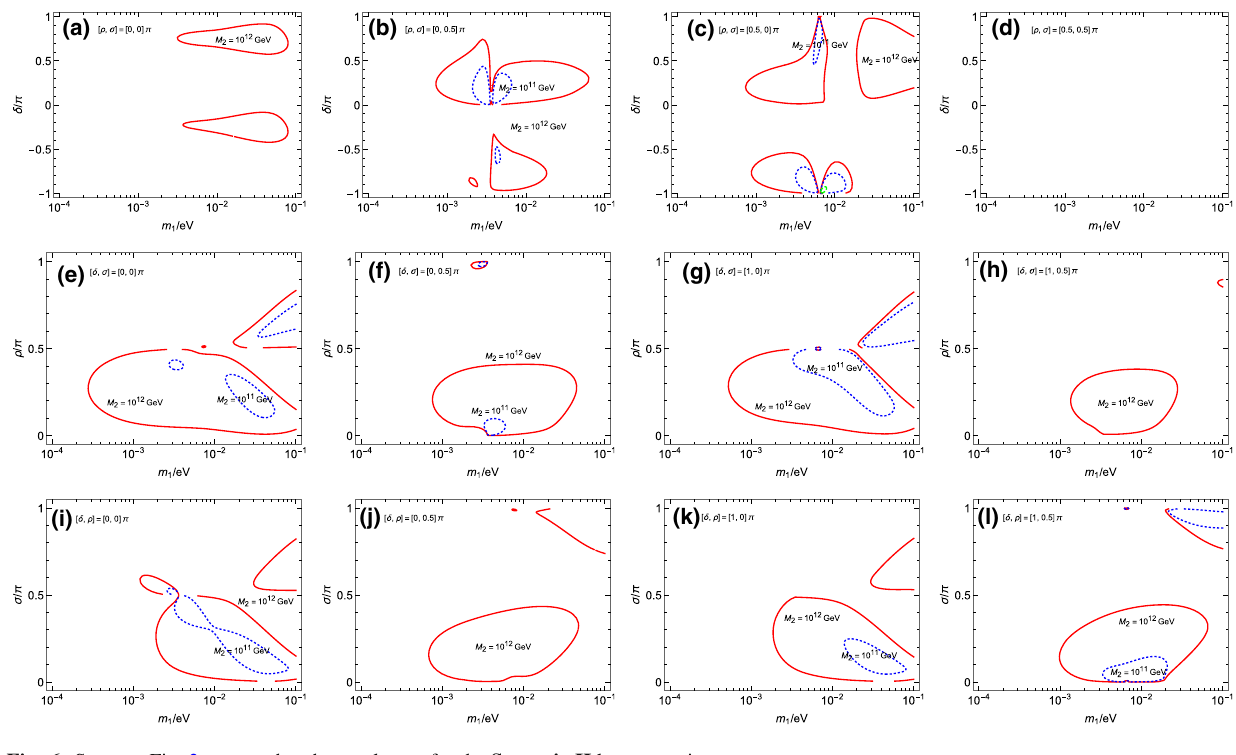
Fig. 6 Same as Fig. 3, except that the results are for the Scenario II leptogenesis